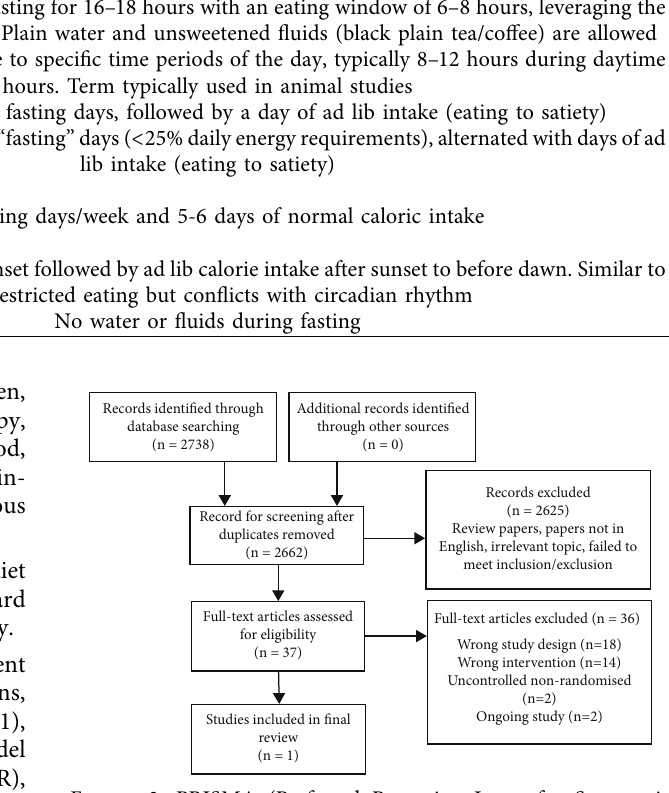
Figure 2: PRISMA (Preferred Reporting Items for Systematic Reviews and Meta-Analyses) diagram of systematic review